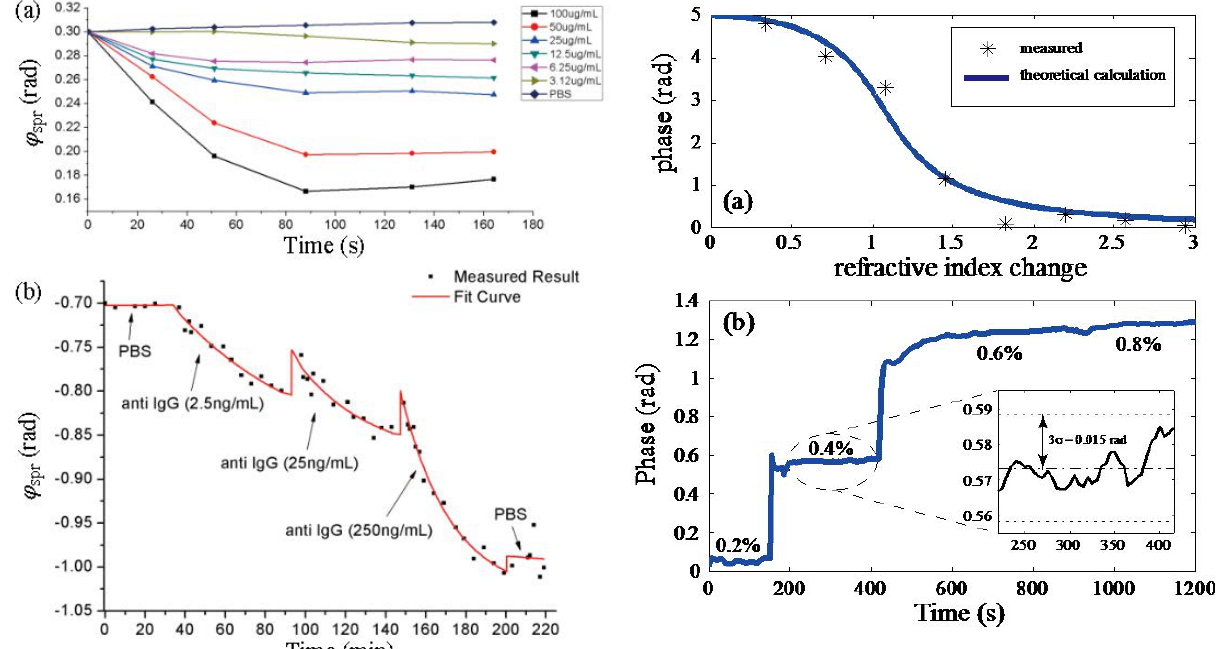
Figure 8: (a) Theoretically calculated and measured phases with respect to the refractive index change (from deionized water) of the cladding materials. (b) Kinetic response of the phase readings. Numbers marked beside the curve indicate the corresponding mass concentrations of the NaCl solutions flowing through the sample. The inset shows a zoomed-in plot of the section marked with the dashed ellipse indicating the noise of the measurement. Adaped from Ref.